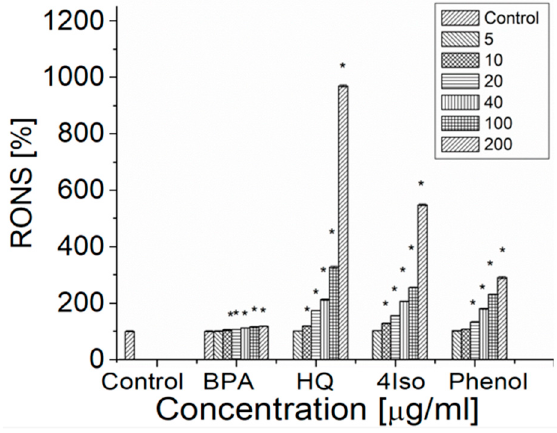
Figure 5. The level of RONS generated in the control erythrocytes and the erythrocytes incubated with BPA, hydroquinone, phenol and 4-isopropylphenol in the concentration range 5–200 μ g/mL after 24 h of incubation. The data are presented as the means ± SE. * the effects of compounds were statistically significant.